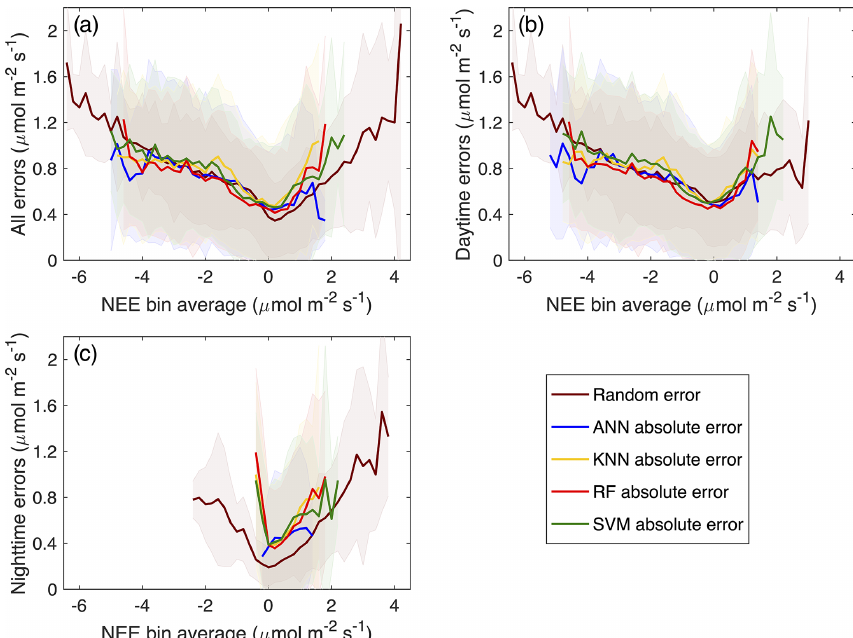
Figure 5. Comparison of NEE measurement and model uncertainties of the gap-filling algorithms using the data and the daytime and nighttime data. The random measurement error is estimated by Finkelstein and Sims (2001). The bin width is 0.2µmolm − 2 s − 1 , and bins with fewer than 10 data points are